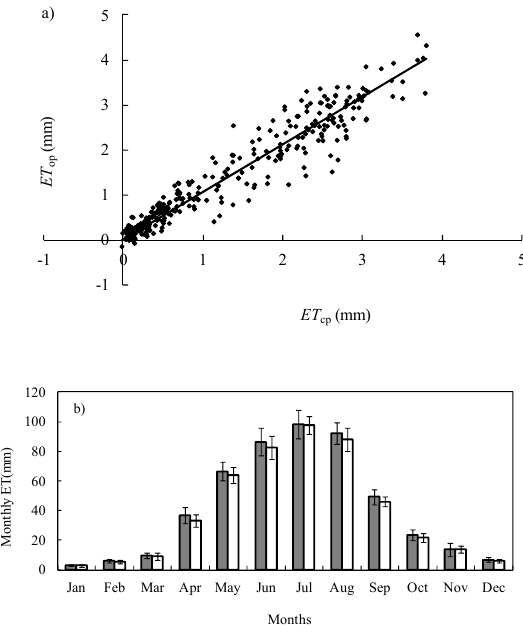
Figure 6. Open-path system measured daily evapotranspiration (ET op ) vs. closed-path daily evapotranspiration (ET cp ) during the observation period at the Changbai Mountains forest site (a) . The analysis was based on 244 data points. Year-round comparative measurements of monthly ET rates by using open- (filled bars) and closed path system (open bars) at the Changbai Mountains forest flux site (b) . Error bars refer to the random uncertainty of fluxes. Latent heat fluxes were converted from energy to water vapor units by multiplication with the latent heat of